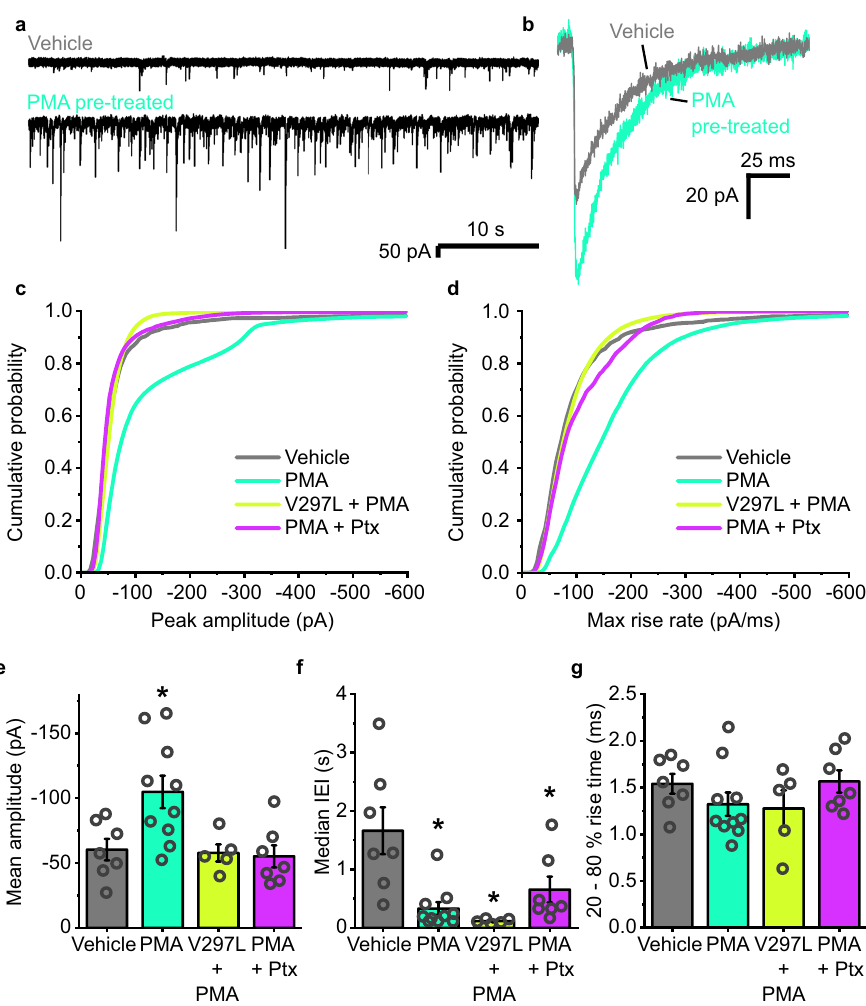
Fig. 9 Induction of iLTP by PKC requires GABA A R activation and desensitization. a Representative sIPSC traces recorded from cells pretreated with either vehicle (black) or phorbol 12-myristate 13-acetate (PMA, green). b Average waveforms of sIPSCs for each condition. c Mean cumulative probability distributions of the amplitudes of all sIPSCs recorded for each receptor construct (WT or α 2 V297L ) and condition (vehicle, grey; + PMA, turquoise; α 2 V297L + PMA, light green; + PMA & picrotoxin (Ptx), purple); n = 1482 events from 7 neurons, 12,532 events from 10 neurons, 11,170 events from 5 neurons and 4745 events from 7 neurons, respectively. d Cumulative probability distributions of the maximum rate of rise slopes of all sIPSCs recorded as in panel ( c ). e Summary data for mean sIPSC amplitudes recorded from cells pretreated with either vehicle or PMA, or cells expressing α 2 V297L and pretreated with PMA, or pretreated with PMA in the presence of picrotoxin (100 µ M; one-way ANOVA: F (3,25) = 5.84, p = 0.0036; Tukey test (vehicle vs PMA): p = 0.022; Tukey test (vehicle vs PMA + Ptx): p = 0.98; Tukey test (vehicle, α 2 V297L + PMA): p = 0.99). f Median sIPSC IEIs under the same four conditions as in ( e ) (one-way ANOVA: F (3,25) = 8.03, p = 0.0006; Tukey test (vehicle vs PMA): p = 0.0013; Tukey test (vehicle vs α 2 V297L + PMA): p = 0.0016; Tukey test (vehicle vs PMA + Ptx: p = 0.030). g Mean 20 – 80% rise time of sIPSCs for neurons recorded under the indicated conditions (one-way ANOVA: F (3,25) = 1.15, p = 0.35). Source data are provided as a Source data fi le for Fig.